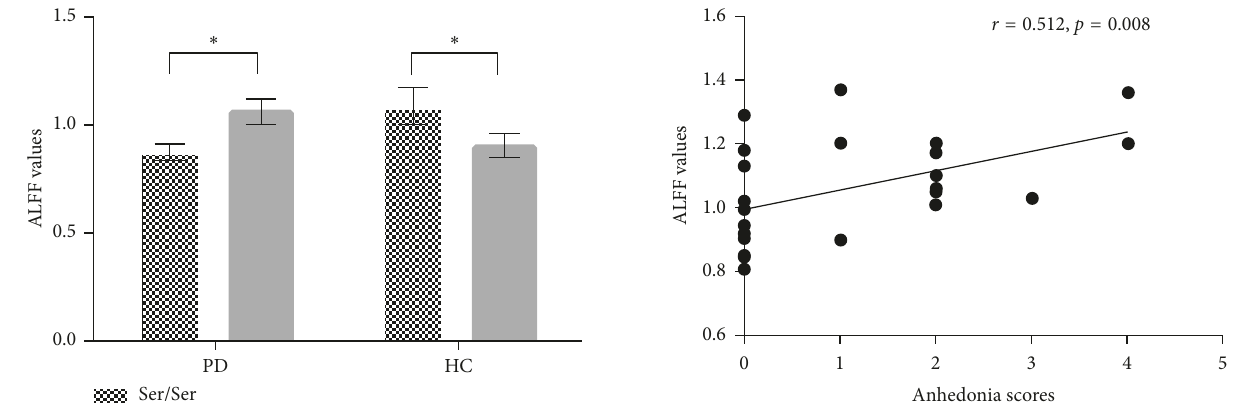
Figure 5: Correlation analysis between ALFF values in the right Figure 3: Post hoc tests of the interaction between groups and medial frontal gyrus and anhedonia scores. ALFF values in the right medial frontal gyrus affected by the interaction between groups and genotypes. Post hoc tests were corrected by Bonferroni correction genotypes were negatively correlated with anhedonia scores with a significant different p 0 . 0083 (0.05/6 (number of pair- ( r 0.512, p 0 . 008) in the Gly carriers in the PD group. Ab- comparisons)). ALFF values in the right medial frontal gyrus were (cid:30) (cid:30) breviations: PD, Parkinson’s disease; ALFF, amplitude of low- increased in the PD group with the Ser/Gly or Gly/Gly genotypes < frequency when compared to the Ser/Ser genotype, while it was decreased in the control group with the Ser/Gly or Gly/Gly genotypes when compared to the Ser/Ser genotype. Abbreviations: PD, Parkinson’s disease; HC, healthy control; ALFF, amplitude of low-frequency fluctuations; DRD3, dopamine receptor D3 gene.